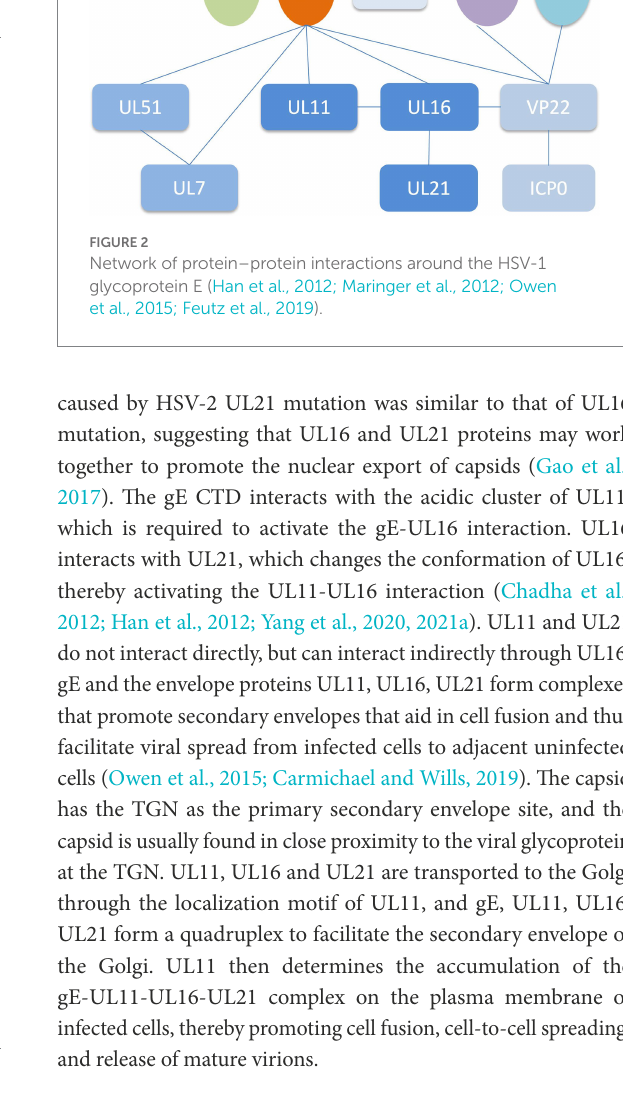
TABLE 1 Properties and functions of gE-interacting envelope proteins in HSV-1. HSV-1